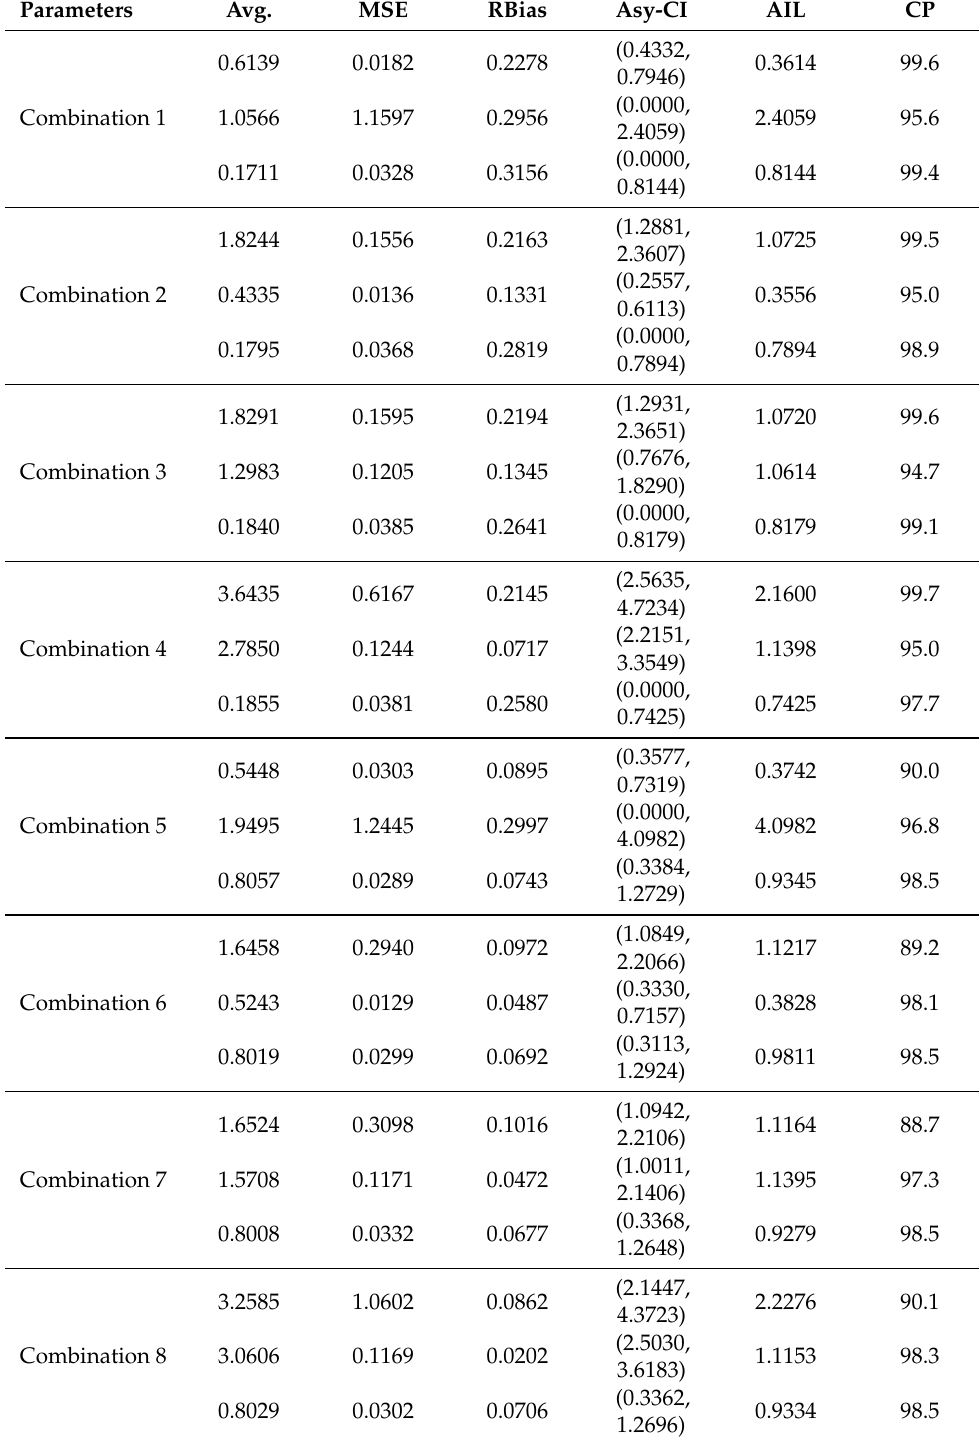
Table 11. Average estimated values, MSEs, CIs, AILs and CPs (in %) of the MLE for the FB distribution at N = 100 and n =